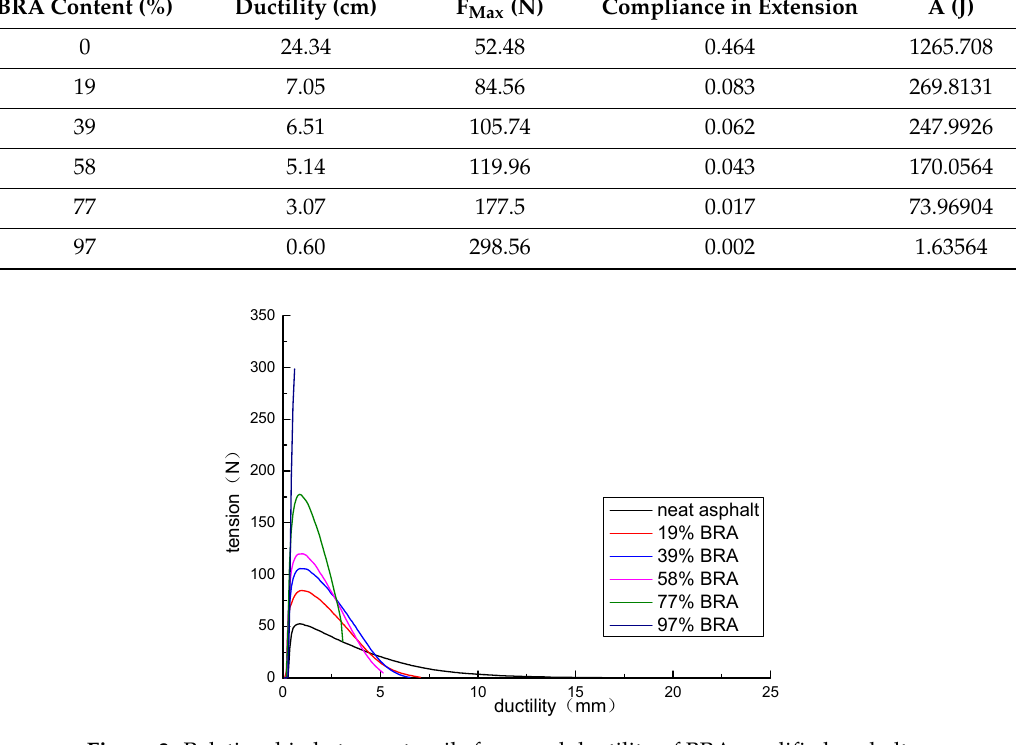
Figure 3. Relationship between tensile force and ductility of BRA-modified asphalt.